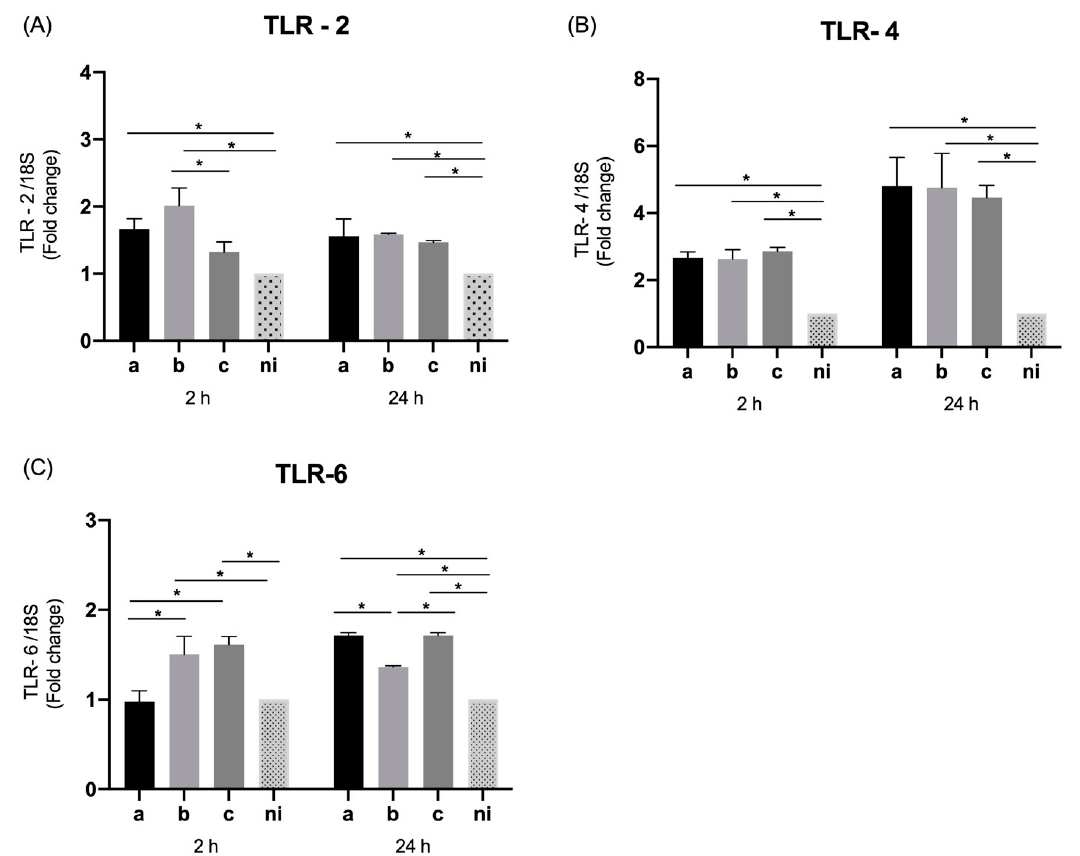
Figure 3. Toll like receptors (TLR) mRNA expression by A. actinomycetemcomitans -induced oral epithelial cells (OKF6/TERT2). Expression in oral epithelial cells infected at a MOI = 10 2 with strains ATCC ® 43717 TM (serotype a), ATCC ® 43718 TM (serotype b), and ATCC ® 43719 TM (serotype c), 2 and 24 h after infection. For relative expression, mRNA expression in non-infected (ni) oral epithelial cells was considered as 1, as a reference for fold-change in expression using 18S rRNA expression levels as a normalizing endogenous control. Data are represented as fold-change means and standard deviation of three independent experiments performed in duplicate. ( A ) TLR-2, ( B ) TLR-4, and ( C ) TLR-6. Asterisks were used to indicate a value of p considered statistically significant (* p < 0.05).